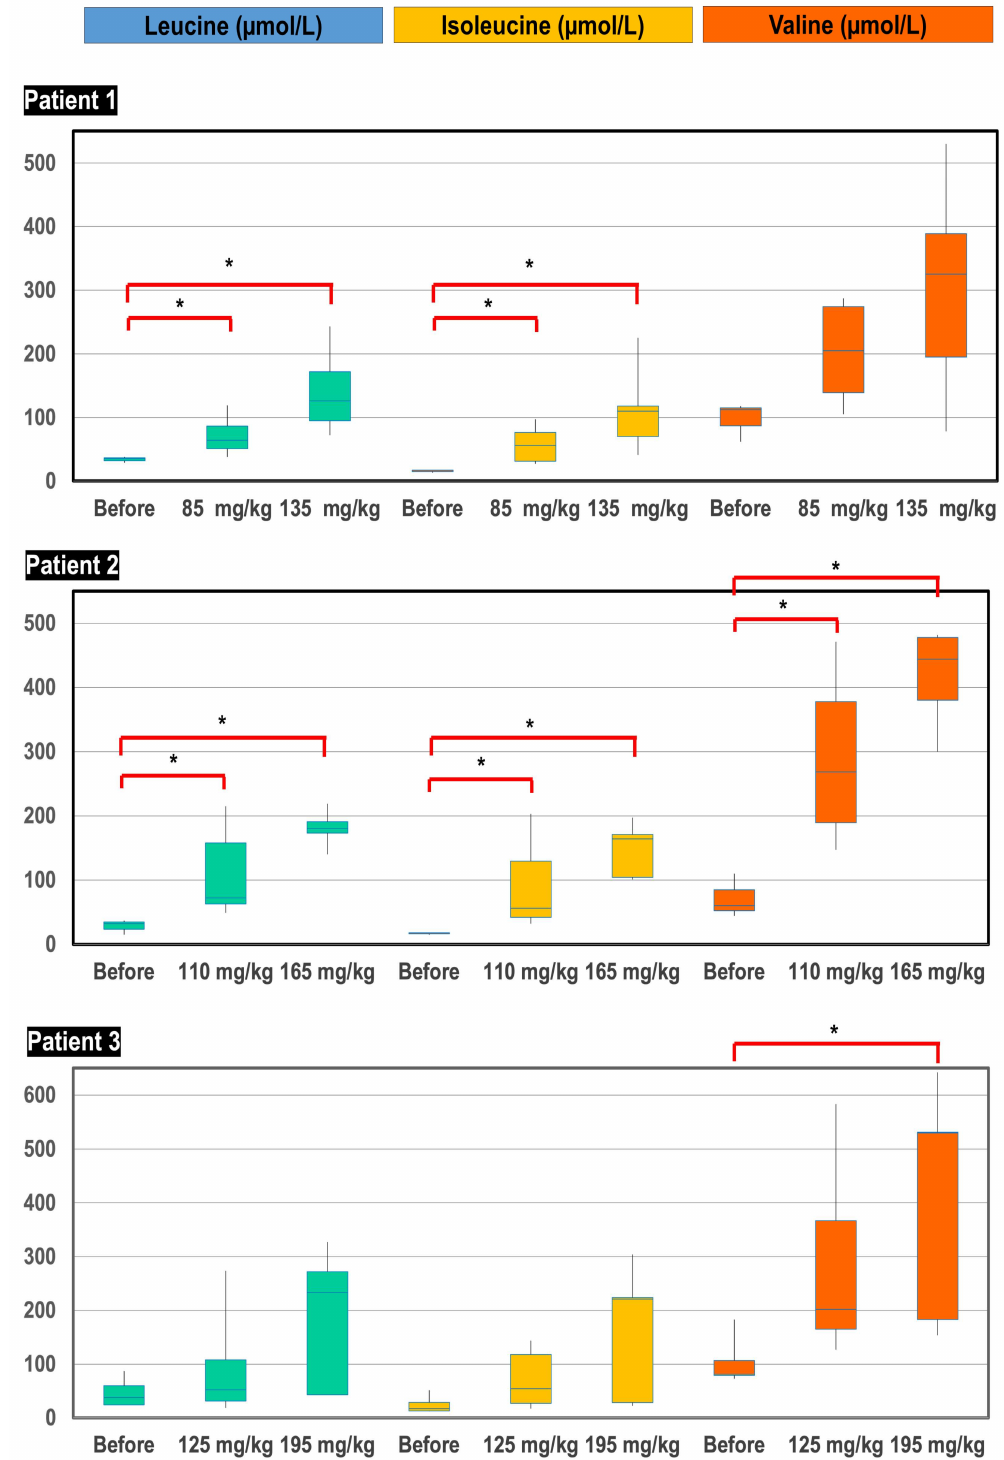
Figure 5. Box-plot distribution of plasma BCAA concentrations ( µ mol/L) before initiation of treat- ment, after supplementation of starting doses of BCAA (85, 110 and 125 mg/kg/day for patient 1, 2 and 3, respectively) and after supplementation of high doses of BCAA (135, 165 and 195 mg/kg/day for patient 1, 2 and 3, respectively). * p -value <